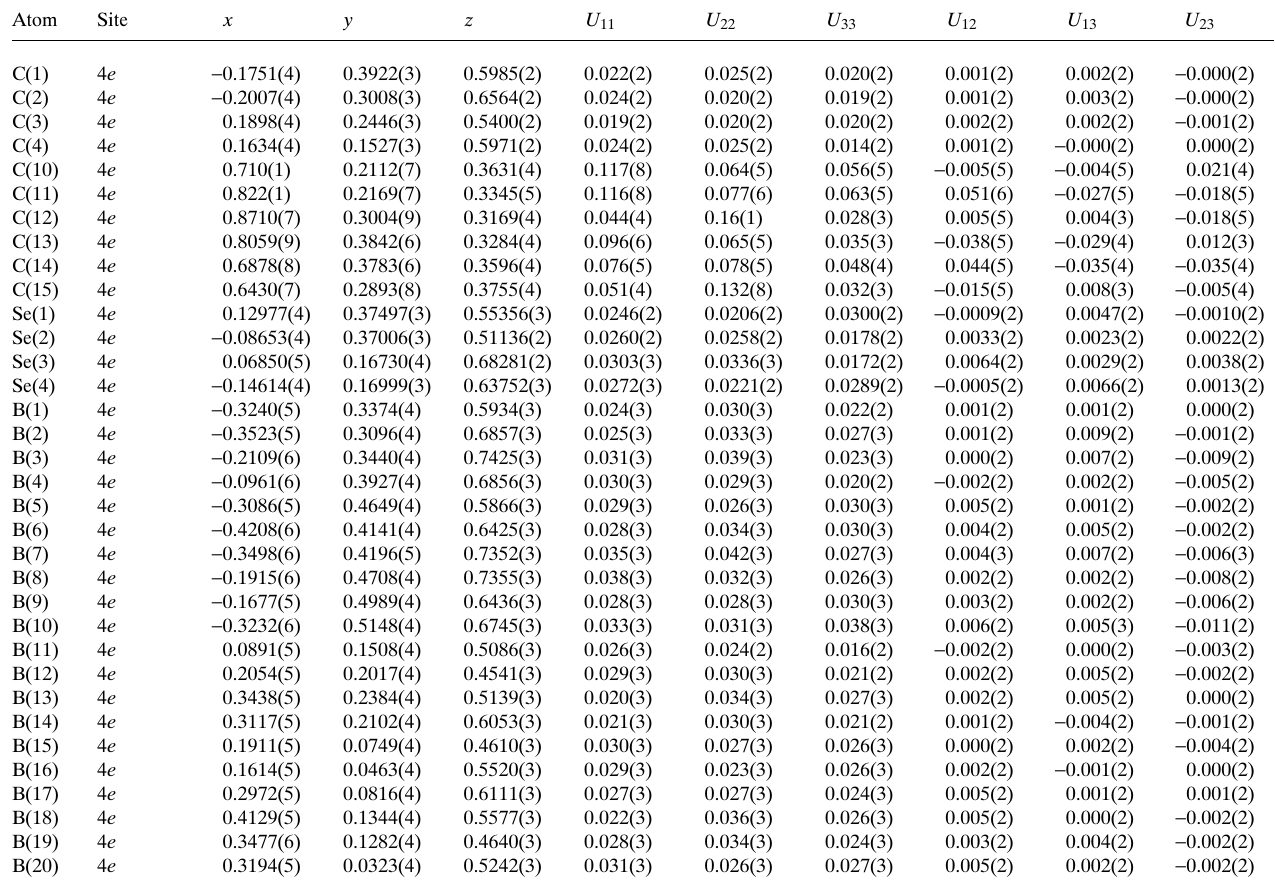
Table 3. Atomic coordinates and displacement parameters (in Å 2 )